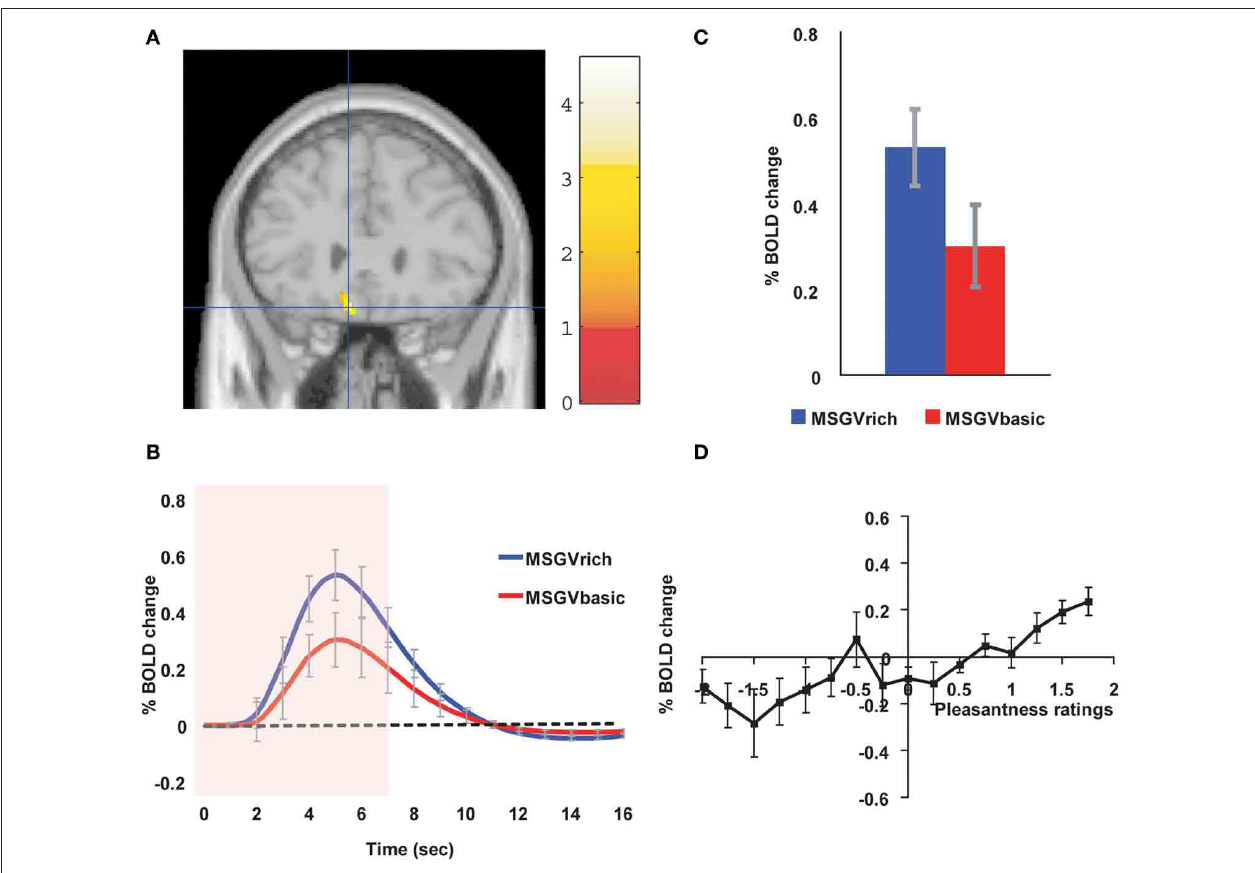
signals for the two conditions. (C) The peak values of the BOLD signal (mean across subjects ± SEM) were significantly different ( t = 3 . 06, df = 11, p = 0 . 01). (D) The BOLD signal in the medial orbitofrontal cortex was correlated with the subjective pleasantness ratings of taste and flavor, as shown by the SPM analysis, and as illustrated (mean across subjects ± SEM, r = 0 . 86, p < 0 . 001). [Reproduced with permission from Grabenhorst et al.